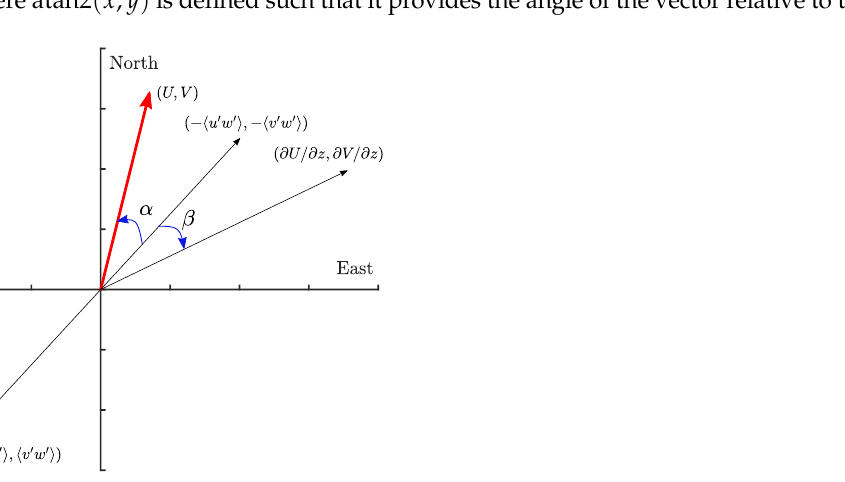
Figure 1. Definition of α and β relative to the mean wind vector, the vertical gradient of the mean horizontal wind speed vector and the stress